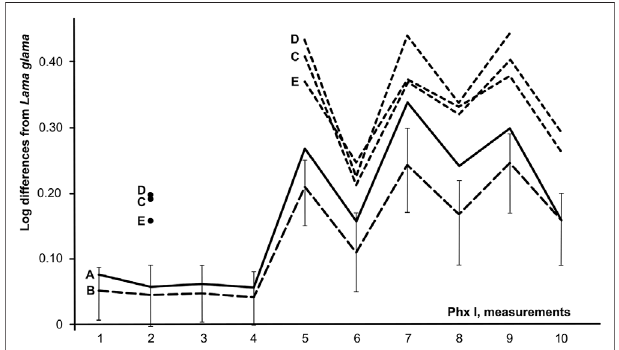
FIGURE 5 | Ratio diagrams of fi rst phalanges of Camelus spp.: 1 – Kamenka A; 2 – C. bactrianus (n = 18; vertical lines indicate range of variability); 3, 4 – C. knoblochi (Khaveson, 1954); 5 – C. knoblochi (Vasiliev, 2011).Measurements:1-anteriorlength,2-posterior